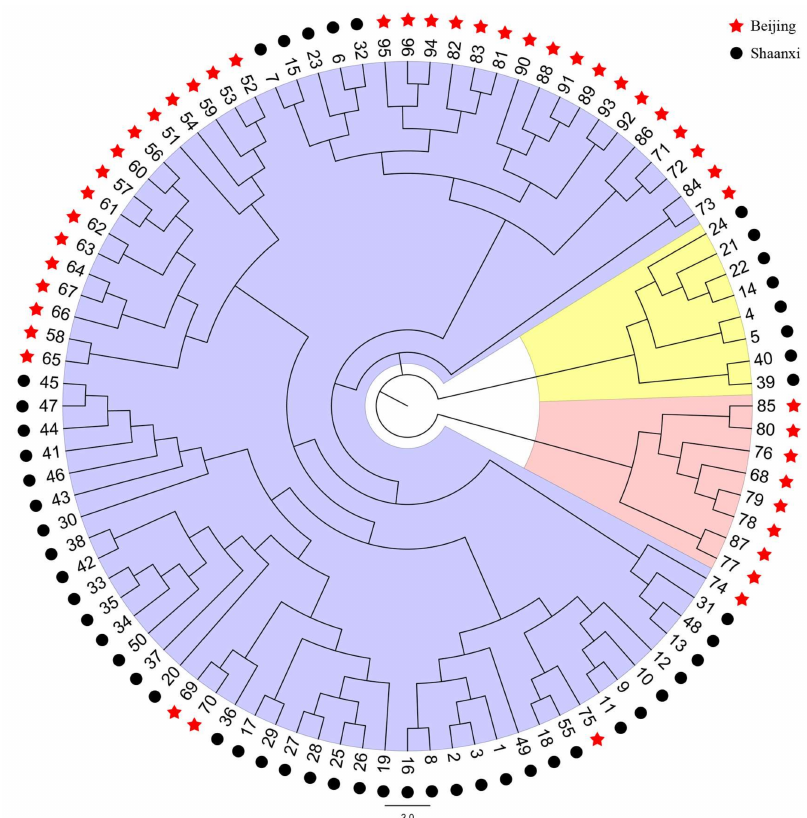
Figure 4. The unweighted pair-group method analysis (UPGMA) tree based on the genetic distance of two G. yamadae populations. Black circle represents individuals in Shaanxi province; red star represents Beijing